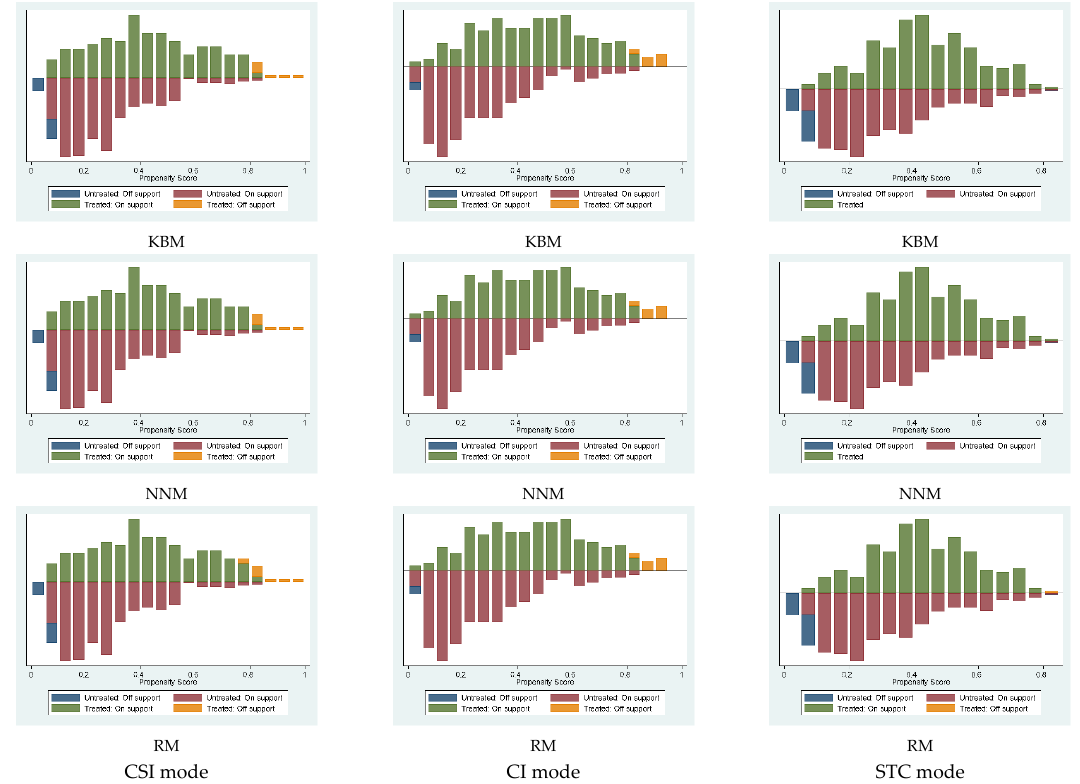
Figure 3. Propensity score distribution and common support for propensity score estimation. Note: 1. KBM, NNM, and RM stands for kernel-based matching, nearest-neighbor matching, and radius matching, respectively; 2. CSI mode, CI mode, and STC mode refers to city-suburb integration mode, characteristic industry mode, and small-town construction mode,